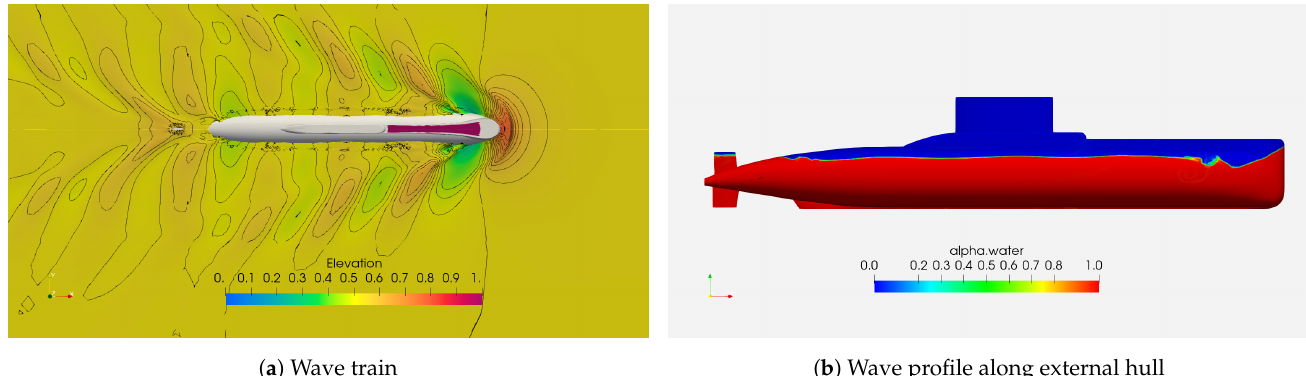
Figure 13. Distribution of wave generated around a Type 209/1300 submarine at condition 1 H / D = 0.33 and Fr = 0.194. This distribution includes contour lines between 0.45–0.80 with steps of 0.025